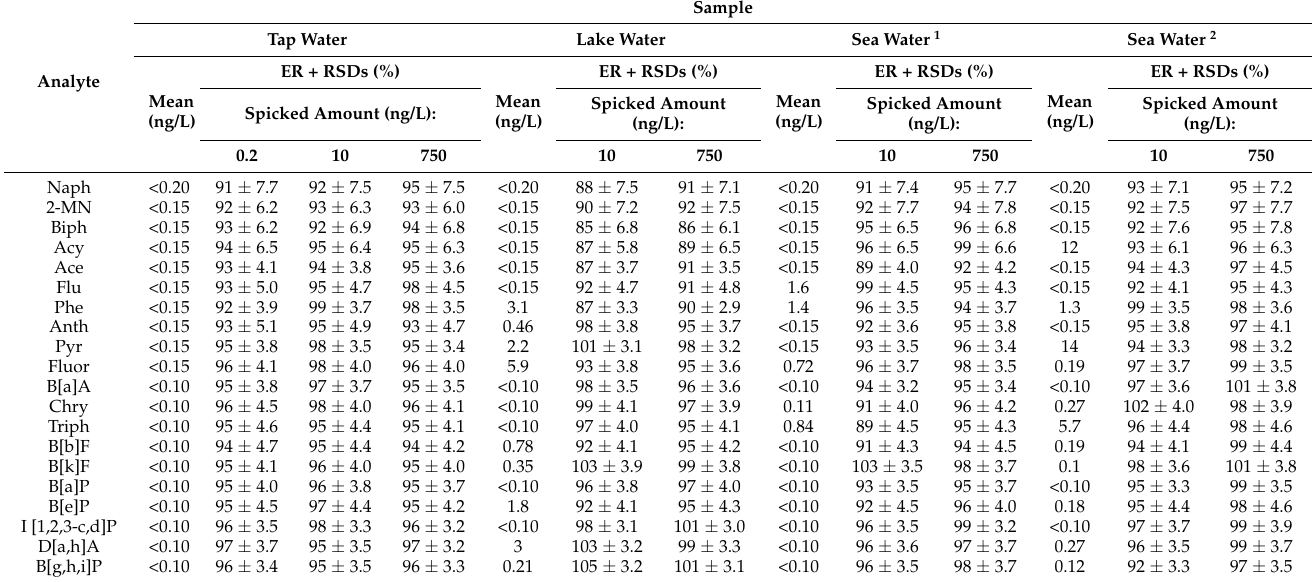
Table 3. Results of HPLC-FD/PDA determination of PAHs in real water samples (n = 2, p = 0.95).